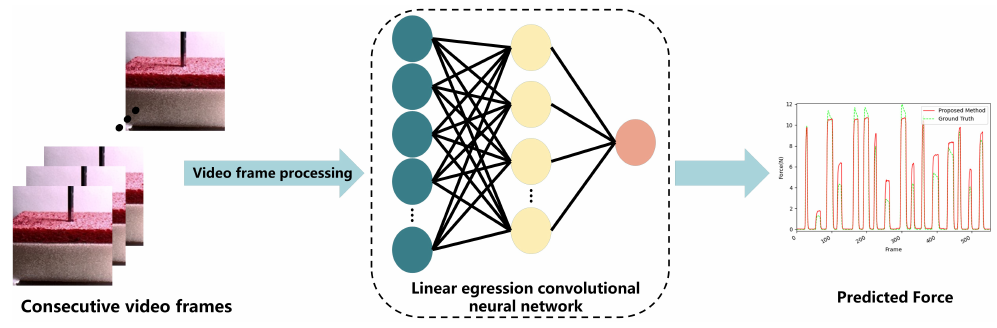
Figure 6. The network structure of the